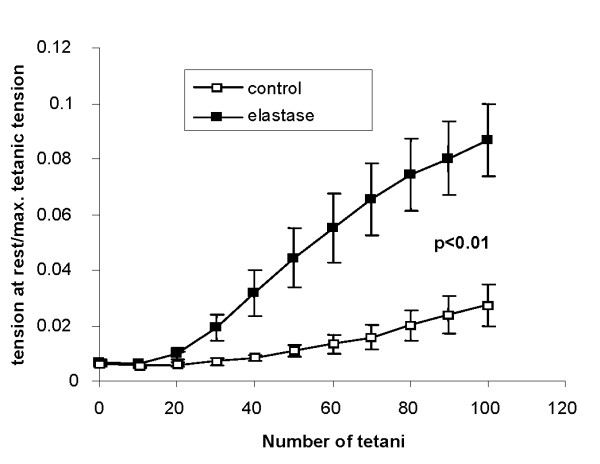
Tension at rest normalized to maximum tetanic tension of isolated longitudinal muscle strips of control and emphysema (protocol 2) mice using repetitive trains of stimuli. Diaphragm muscle strips of elastase treated mice showed incomplete relaxation, while relaxation was unimpaired in preparations from control mice.